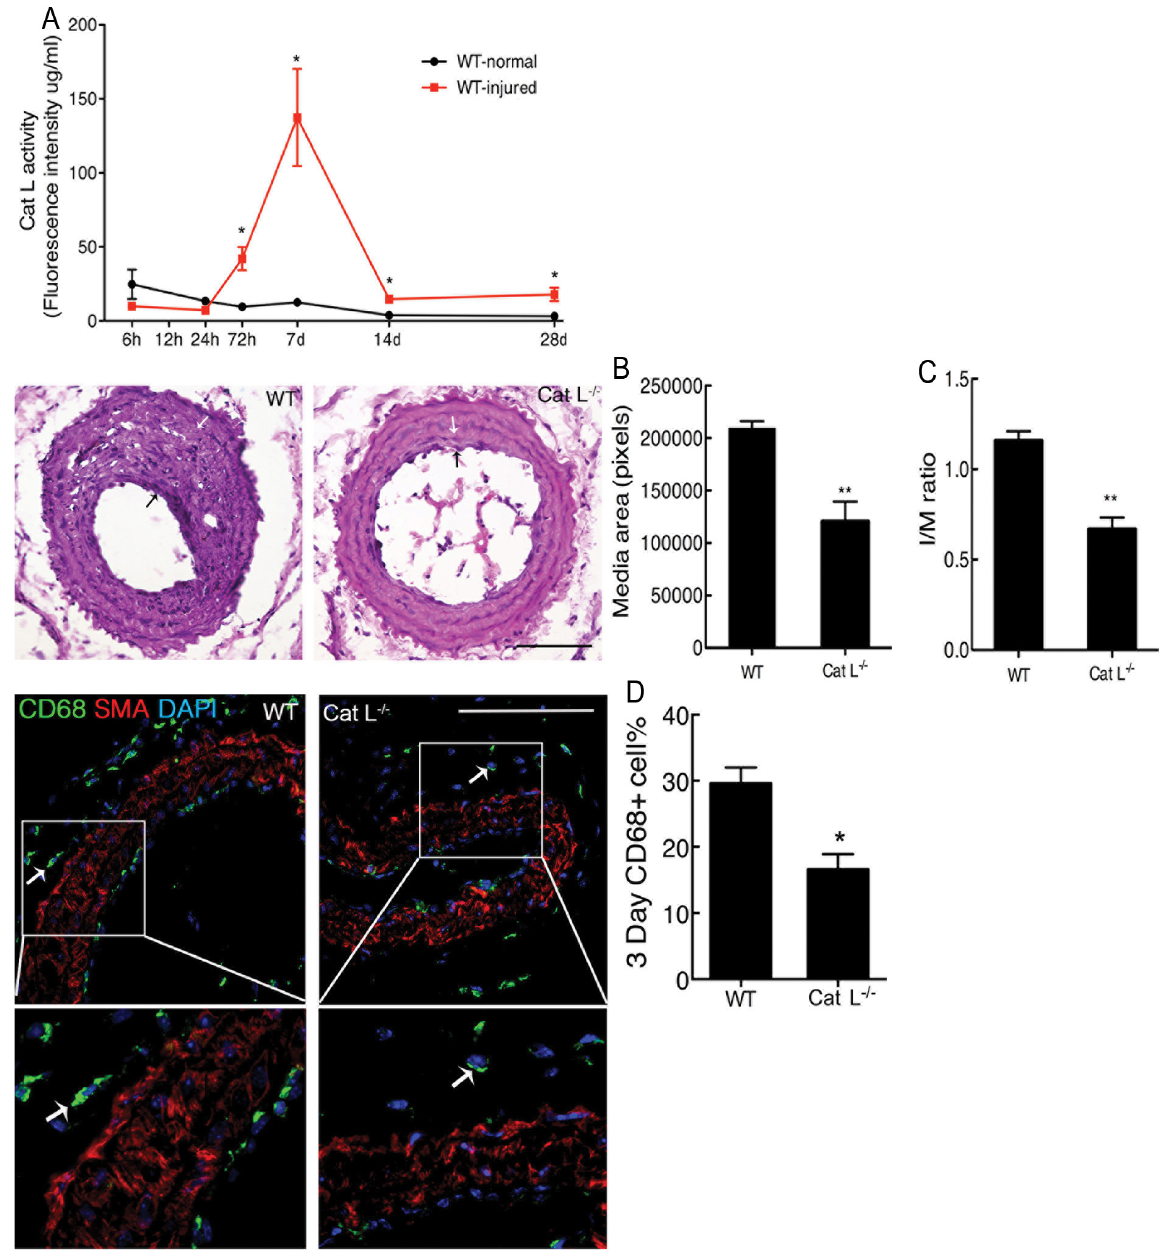
Figure 1. Cathepsin L drives intimal hyperplasia and macrophage infiltration. (A) Arterial enzyme activity for cathepsin L was measured by a fluorescence-based assay and normalized to tissue extract protein concentration at indicated time points following wire injury. Cathepsin L activity of the injured and uninjured carotid arteries from wild-type mice are displayed (n = 4 at each time point). (B,C) Common carotid arteries were injured by a 0.4 mm guide wire plus external carotid artery ligation and harvested 28 d after surgery. Frozen tissues were sectioned. Representative hematoxylin and eosin stained sections of carotid arteries from wild-type mice (n = 6) and cathepsin L -/- mice (n = 6) are shown. The ratios of intima and media area and vessel medial size were quantified by planimetry at 28 d. The white arrows indicate internal elastic lamina. The black arrows indicate luminal side of the artery. (D) Mouse carotid arteries that were immunostained for macrophage markers (CD68-positive cells) 3 d after injury. The number of CD68-positive cells was defined as the percentage of total cells within a given area that stained positive for CD68. Representative hematoxylin and eosin stained and immunofluorescent-stained sections are shown. Data represent the means ± SEM. * P <0.05, ** P <0.01 versus respectively controls. Scale bar represents 100